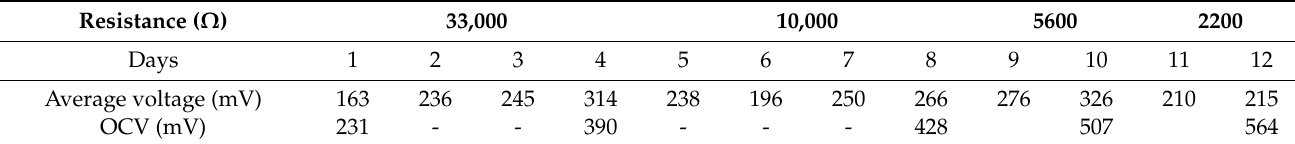
Table 3. Results of the acclimation phase on the single cell.